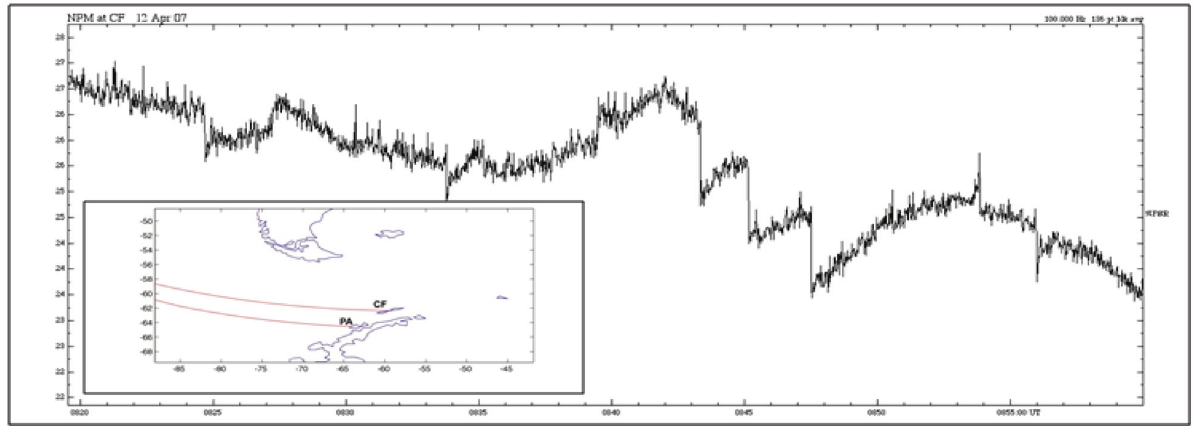
Figure 1. Typical amplitude of the VLF disturbance event profile detected at 21.4 kHz (NPM station, Hawaii) at the Comandante Ferraz